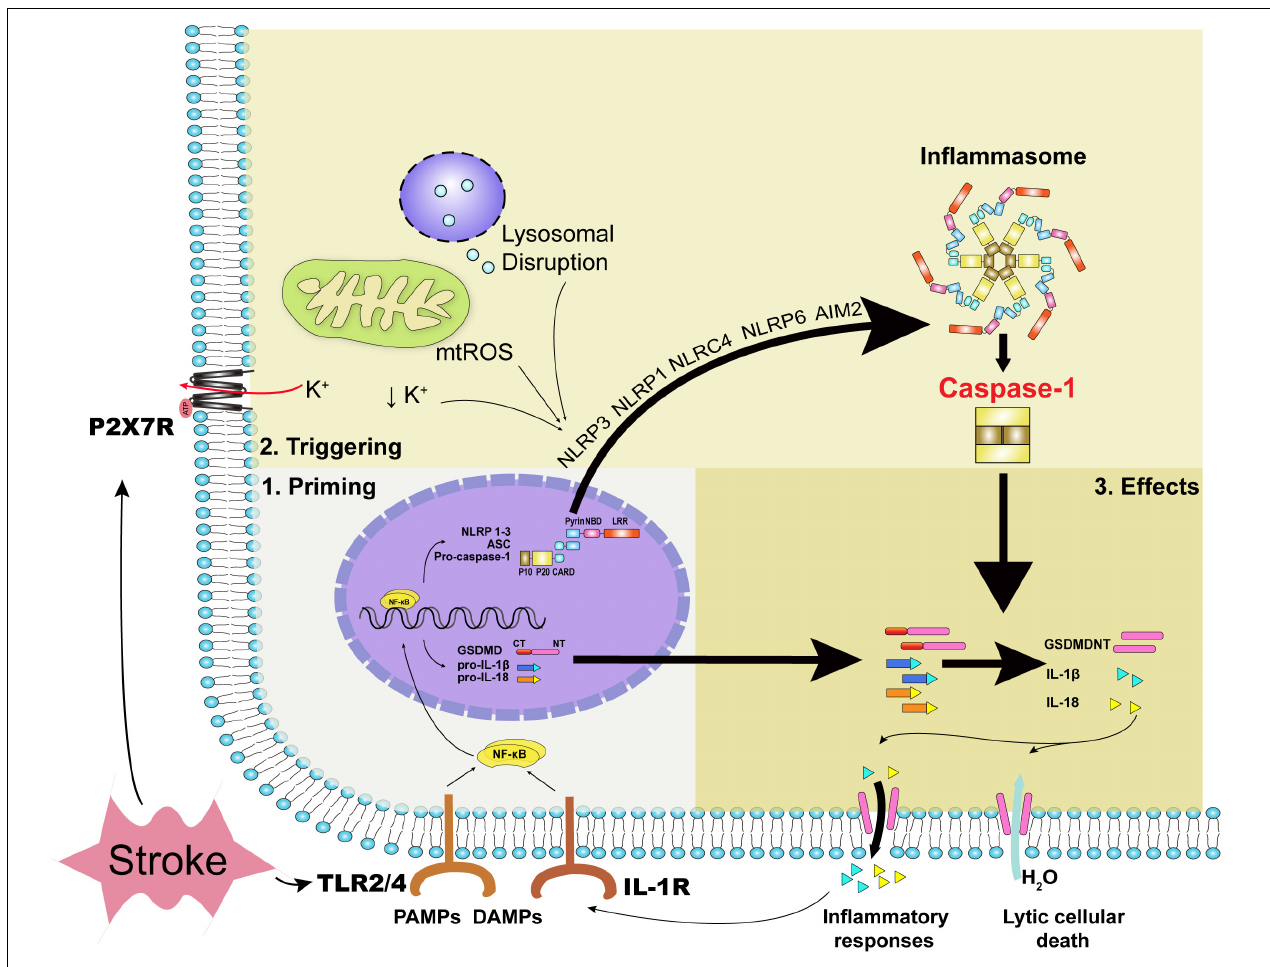
FIGURE 1 | The priming process, triggering process, and executive effects of caspase-1. Acute stroke primarily leads to oxidative stress, disturbance of metabolites, and mechanical stress. DAMPs, inflammatory cytokines together with PAMPs can stimulate the priming process with the transcription of inflammasomes’ constituents and executive components such as pro-IL-1 β , pro-IL-18, and GSDMD. During acute stroke, decreased intracellular potassium concentration, oxidative stress, and lysosomal disruption trigger NLRP3 inflammasome and caspase-1 activation, while dsDNA the form of cytosolic DNA activates caspase-1 via AIM2 inflammasome. Specifically, mechanical stress due to hematoma or edema compression can regulate ATP-gated ion channel P2X7R with potassium efflux. Caspase-1 activation leads to the formation of GSDMDNT and IL-1 β or IL-18, yielding pore formation and inflammatory responses ultimately. DAMPs indicate damage-associated molecular patterns; PAMPs, pathogen associated molecular patterns; NLRP, NOD-like receptor family pyrin domain-containing; NLRC, NOD-like receptor family CARD domain containing; mtROS, mitochondrial reactive oxygen species; AIM2, absent in melanoma 2; TLR, toll-like receptor; GSDMD, gasdermin D; IL, interleukin; GSDMDNT, N-terminal fragment of gasdermin